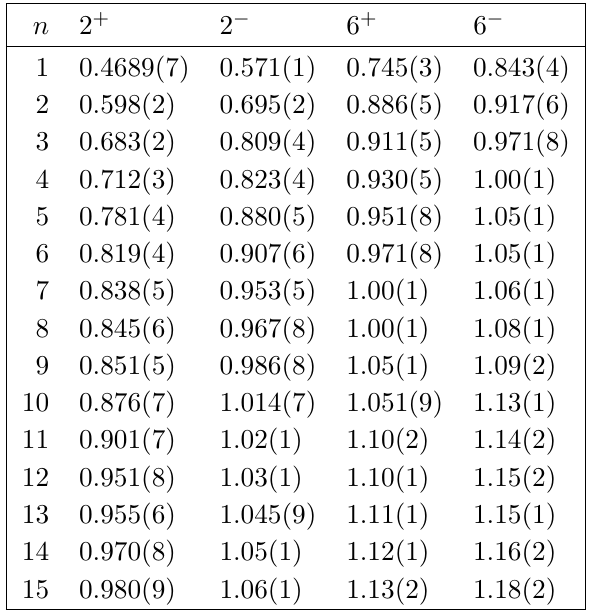
Table 8. Masses for glueballs within A 3 and A 4 representations of Z 4 averaged over P